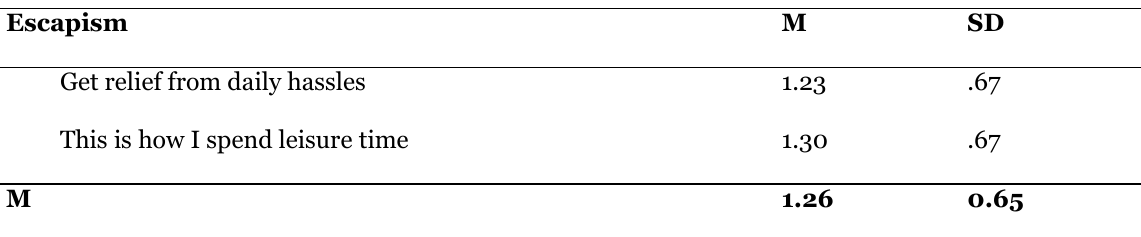
Escapism Factor Escapism